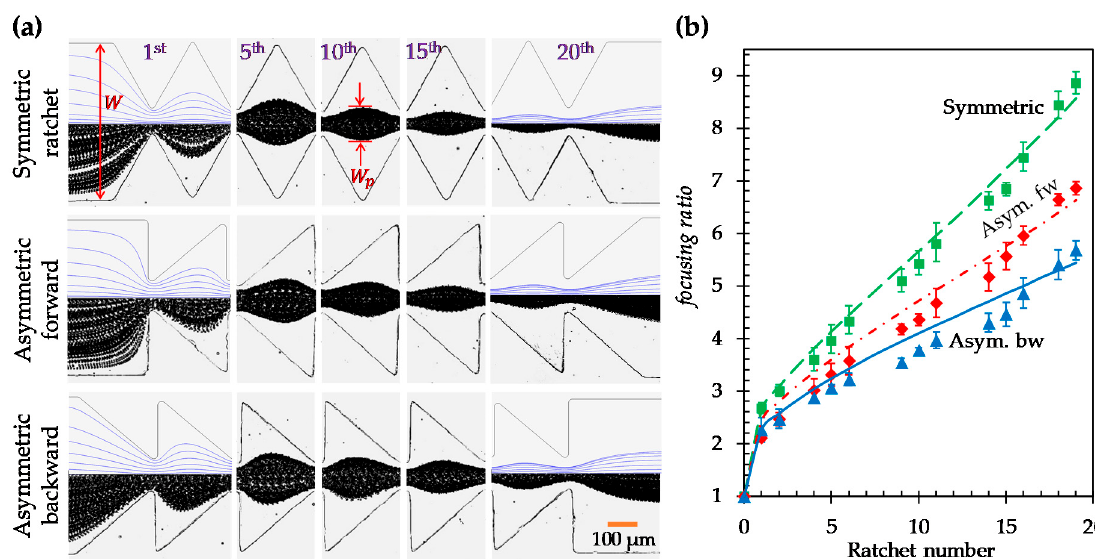
Figure 2. Effect of ratchet structure on the dielectrophoretic focusing of 5 μ m diameter particles: ( a ) Comparison of the experimentally obtained and numerically predicted (top half of the left- and right-most images only) particle trajectories (traveling from left to right) at varying locations of the microchannels with symmetric (top row), asymmetric forward (middle row), and asymmetric backward (bottom row) ratchets, respectively; ( b ) Comparison of the experimentally measured (symbols with error bars) and numerically calculated (curves) particle focusing ratios, defined as the channel width, W , over the particle stream width, W p (see the highlighted dimensions in (a)), among the three ratchet structures.